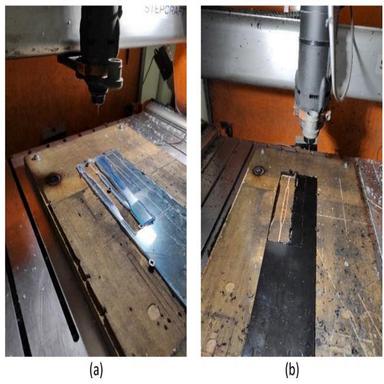
PET (a) and HDPE (b) plates during CNC machining.